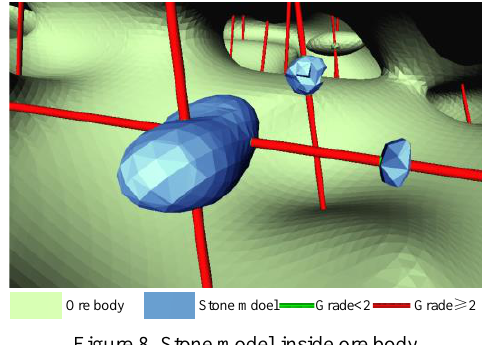
Figure 8. Stone model inside ore body